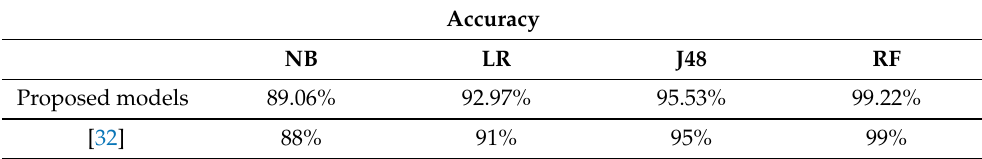
Table 7. Model comparison in terms of accuracy with percentage split (80:20).